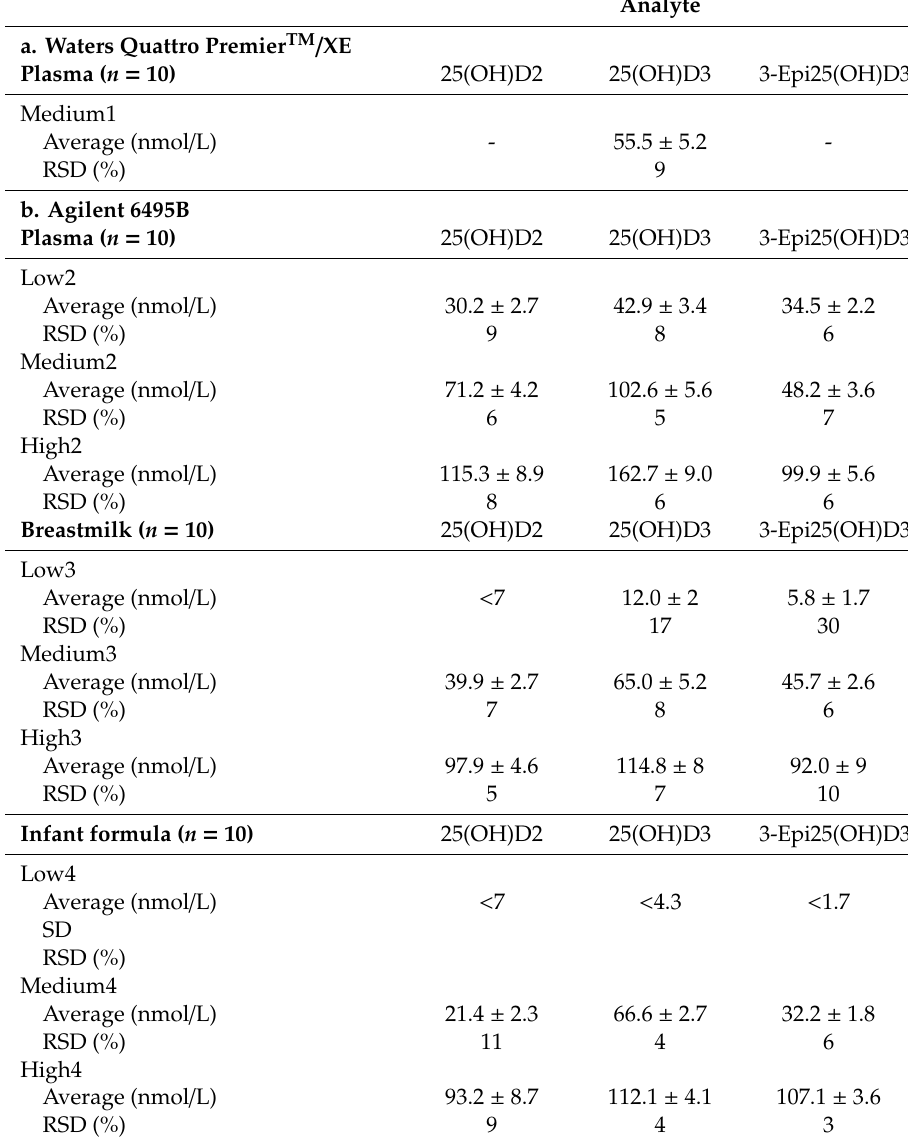
Table 3. Inter-day precision ( n ) of vitamin D metabolites in plasma, breastmilk, and infant